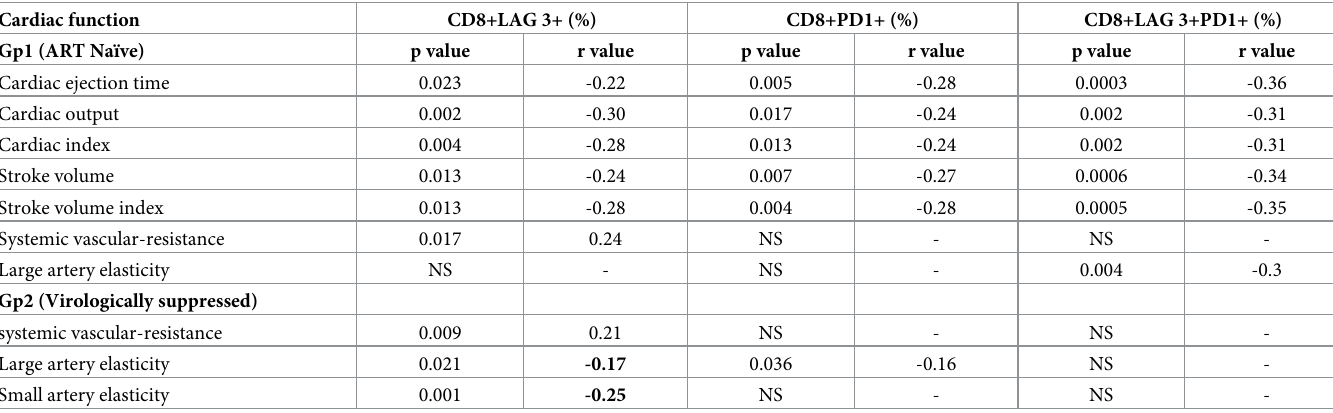
Table 3. Correlations between LAG-3, PD1 and LAG-3+PD1+ expressing CD8 T cells and cardiac function. Cardiac